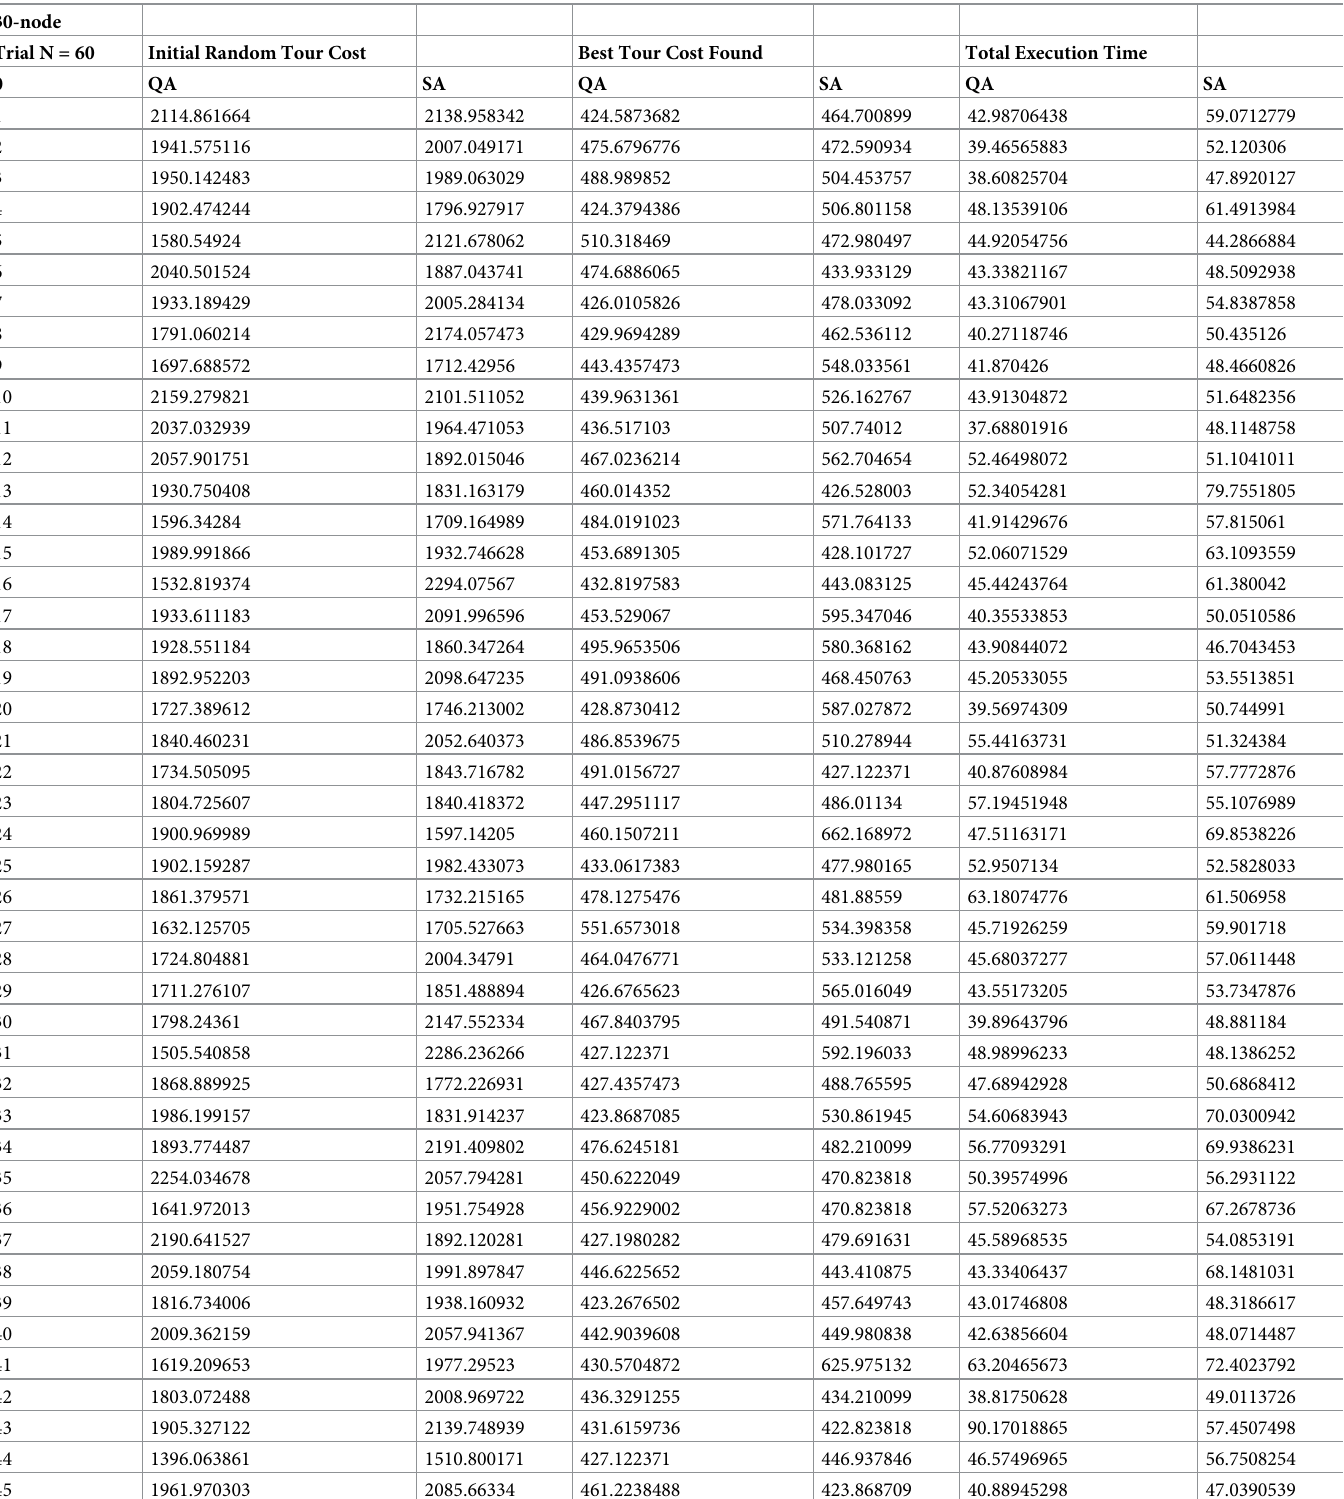
Table 23. Execution results for 30 nodes (n = 30) with samples size N =